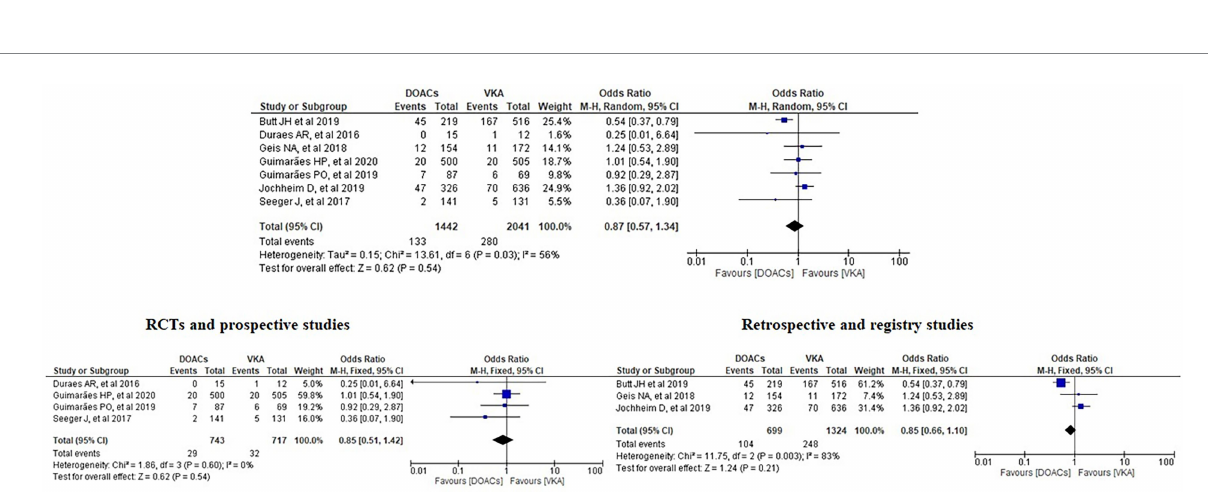
FIGURE 7 Forest plot of all-cause mortality for DOACs compared with VKA along with subgroup analysis. M-H, Mantel–Haenszel test; CI, confidence